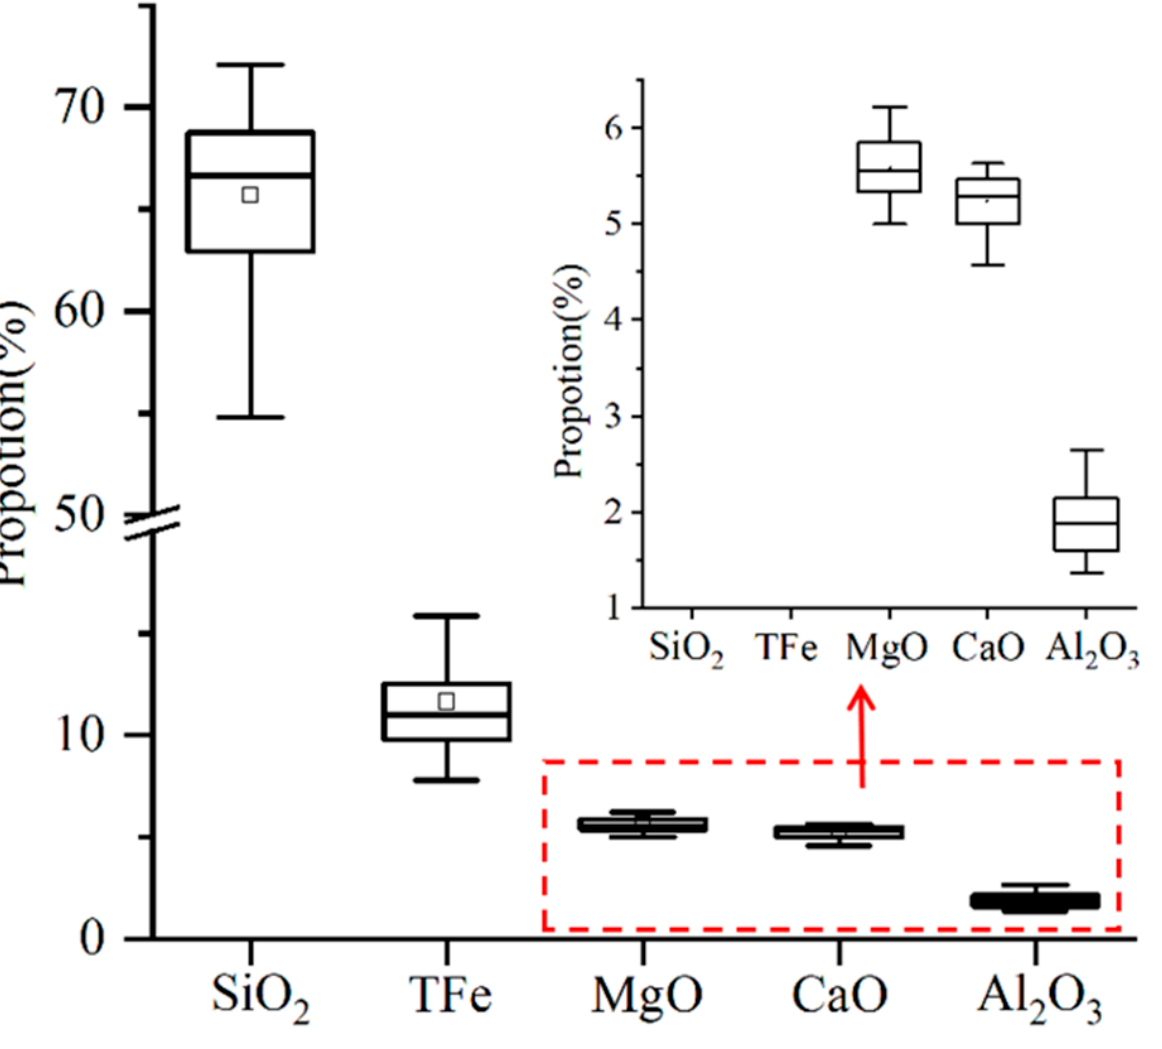
Figure 2. The main chemical elements of tailings.